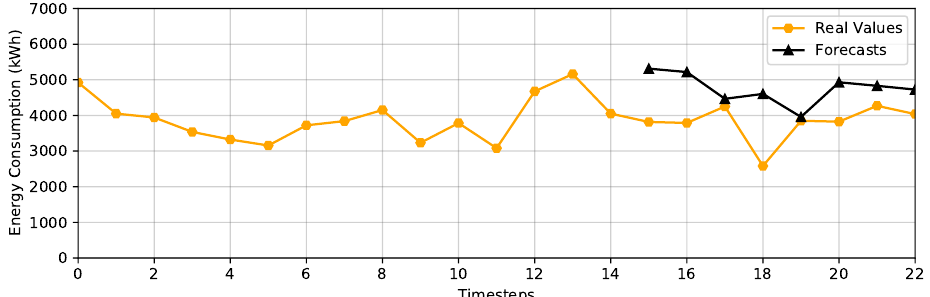
Figure 9. Eight multi-step forecasts for the best candidate model in Method